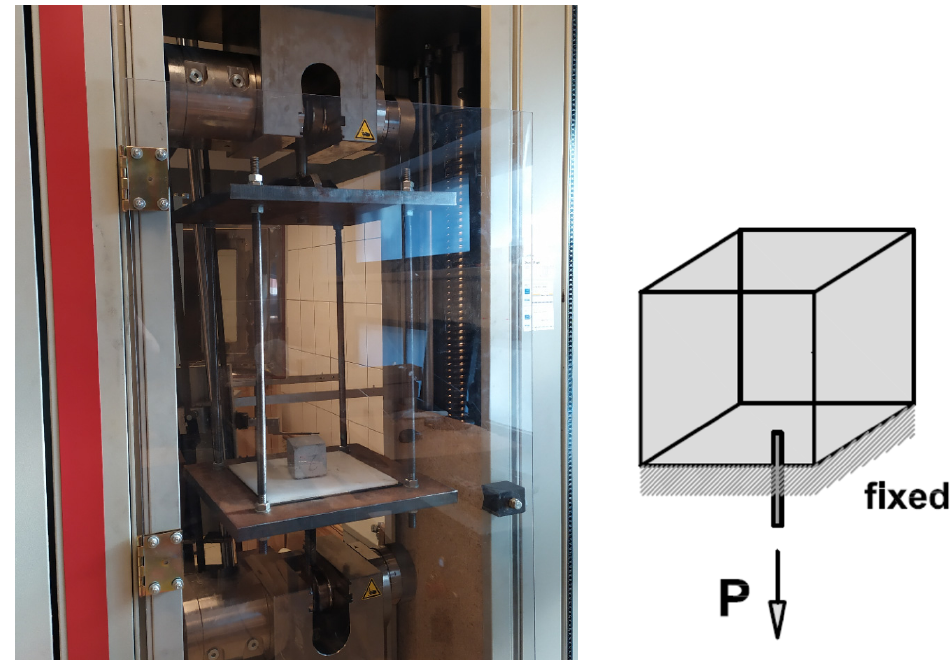
Figure 8. General view of the mechanical testing station.